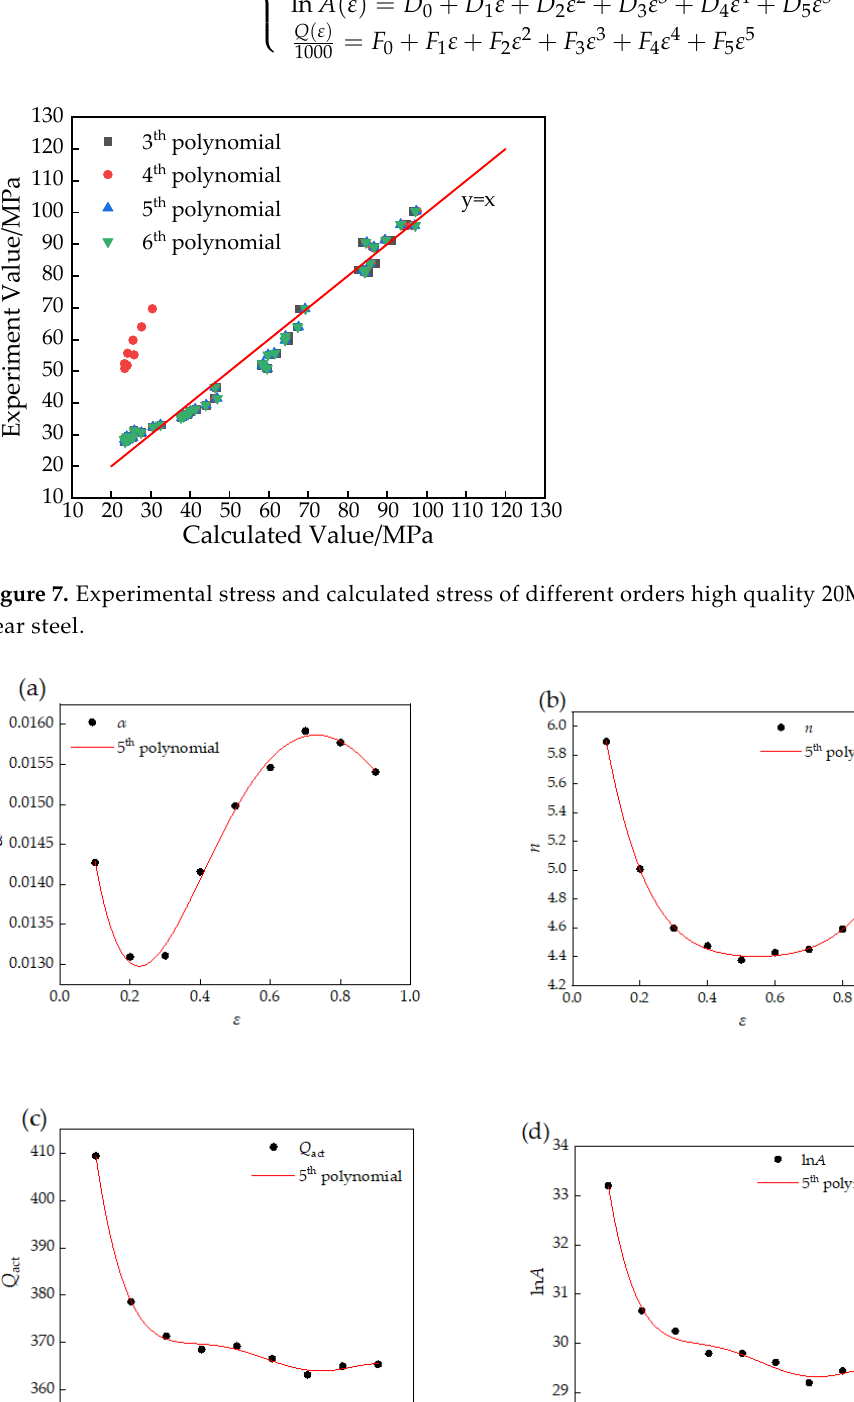
Table 4. Coefficients of polynomial fitting curves for material coefficients. 0